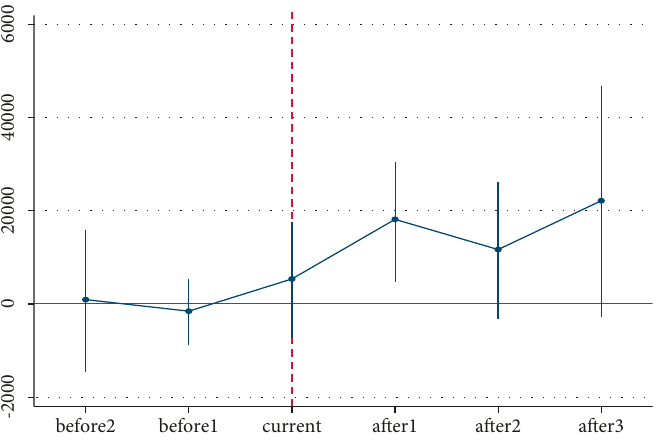
Figure 3: Parallel trends in inbound tourist arrival.